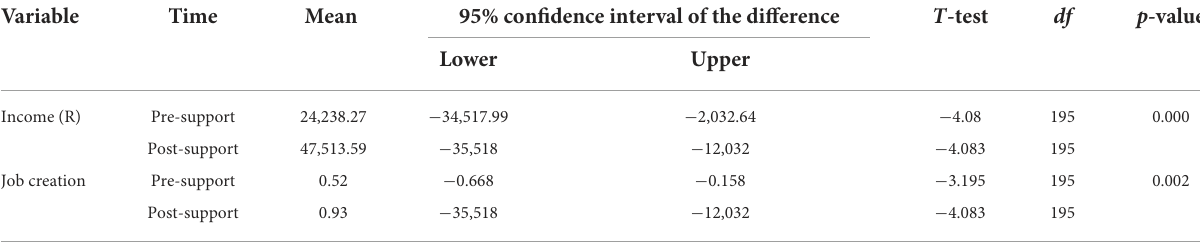
TABLE 3 T -test results of respondents’ net farming income and number of people employed pre- and post-support ( n =